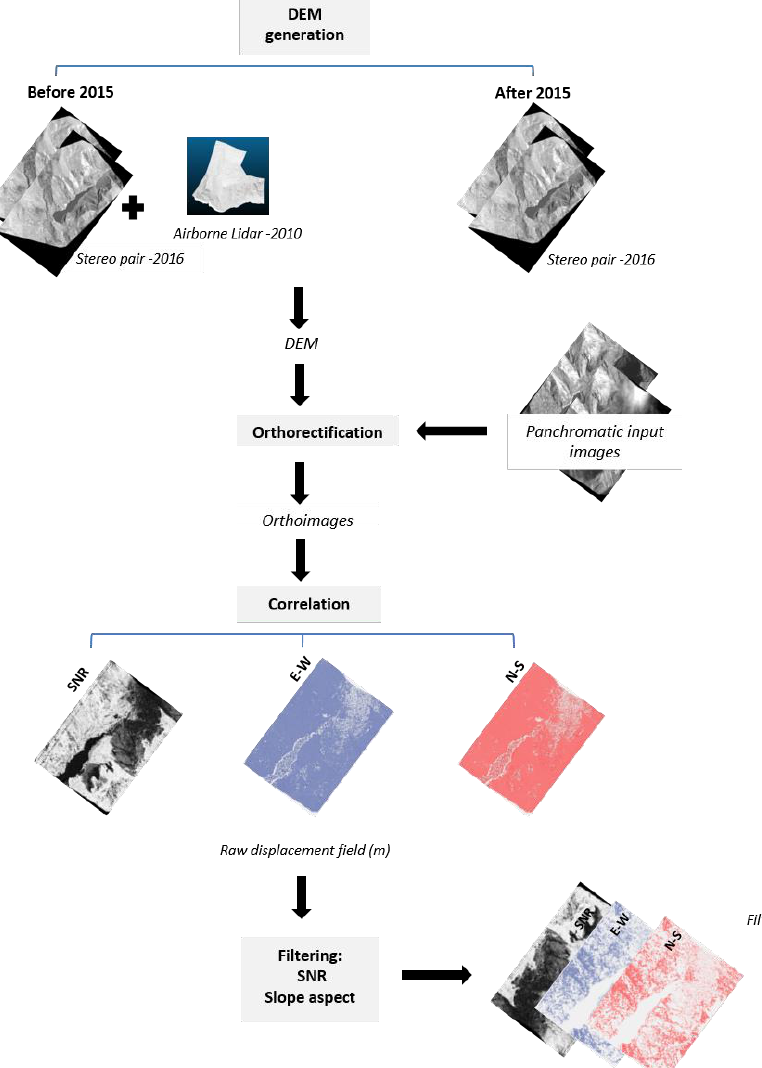
Figure 2. Schematic workflow used to analyze VHR satellite images.